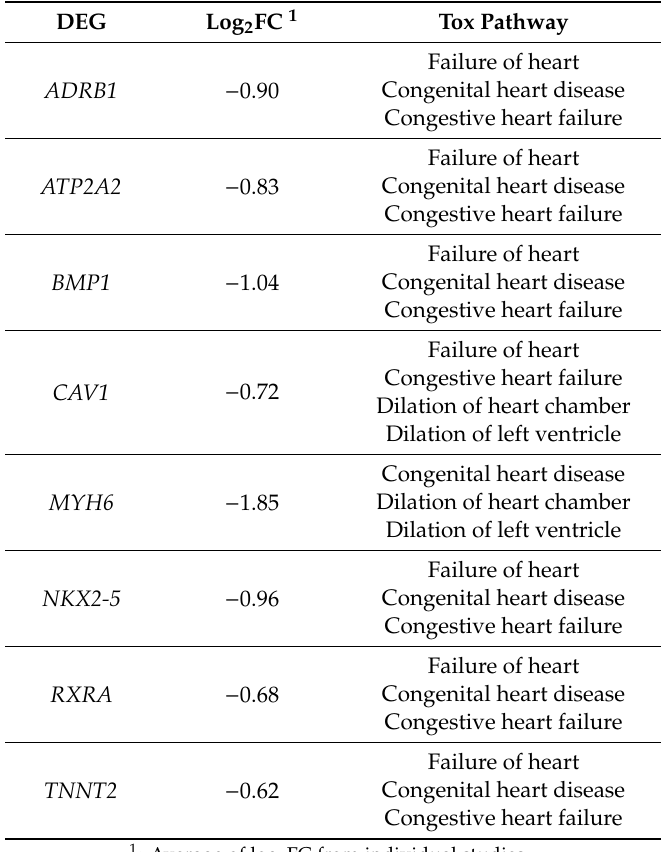
Table 4. DEGs common among three or more toxicity pathways through IPA-Tox